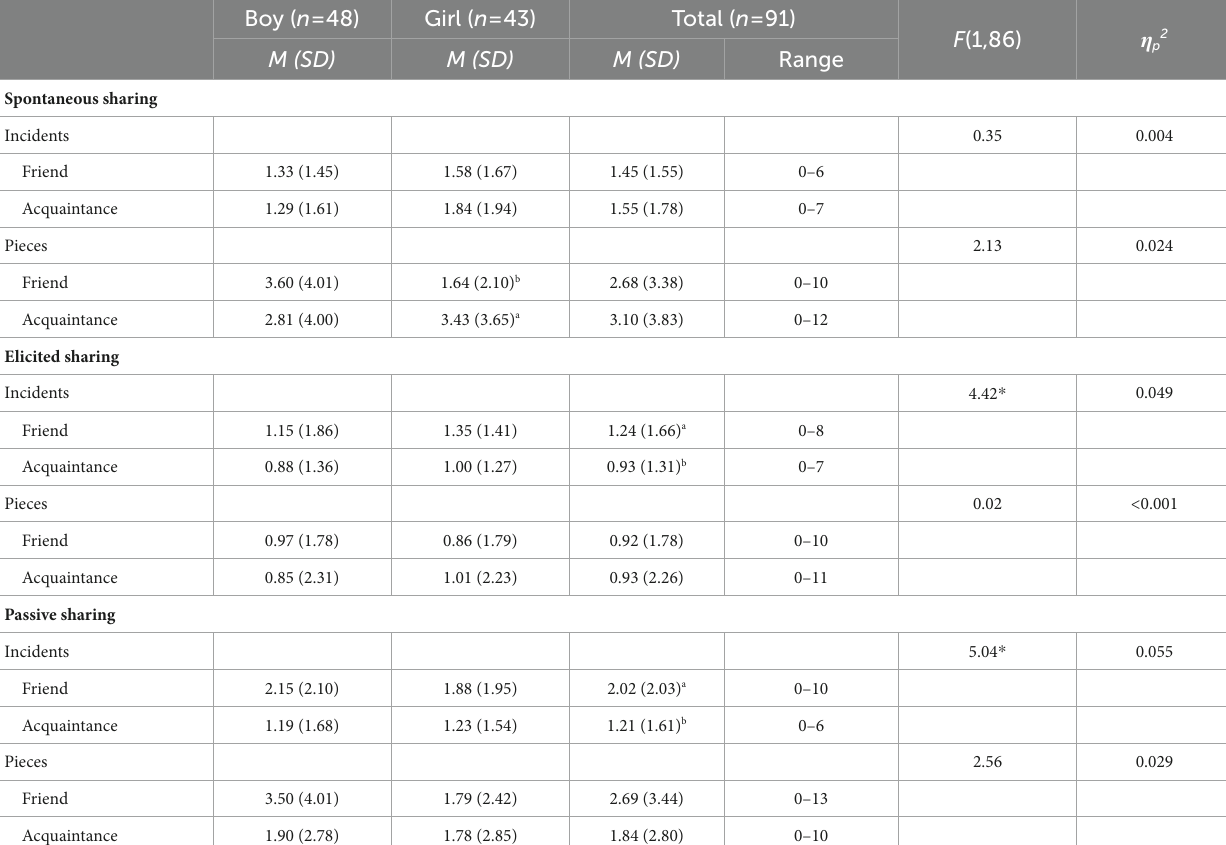
TABLE 3 Means and standard deviations for spontaneous, elicited, and passive sharing with friends and acquaintances, separately for boys and girls.